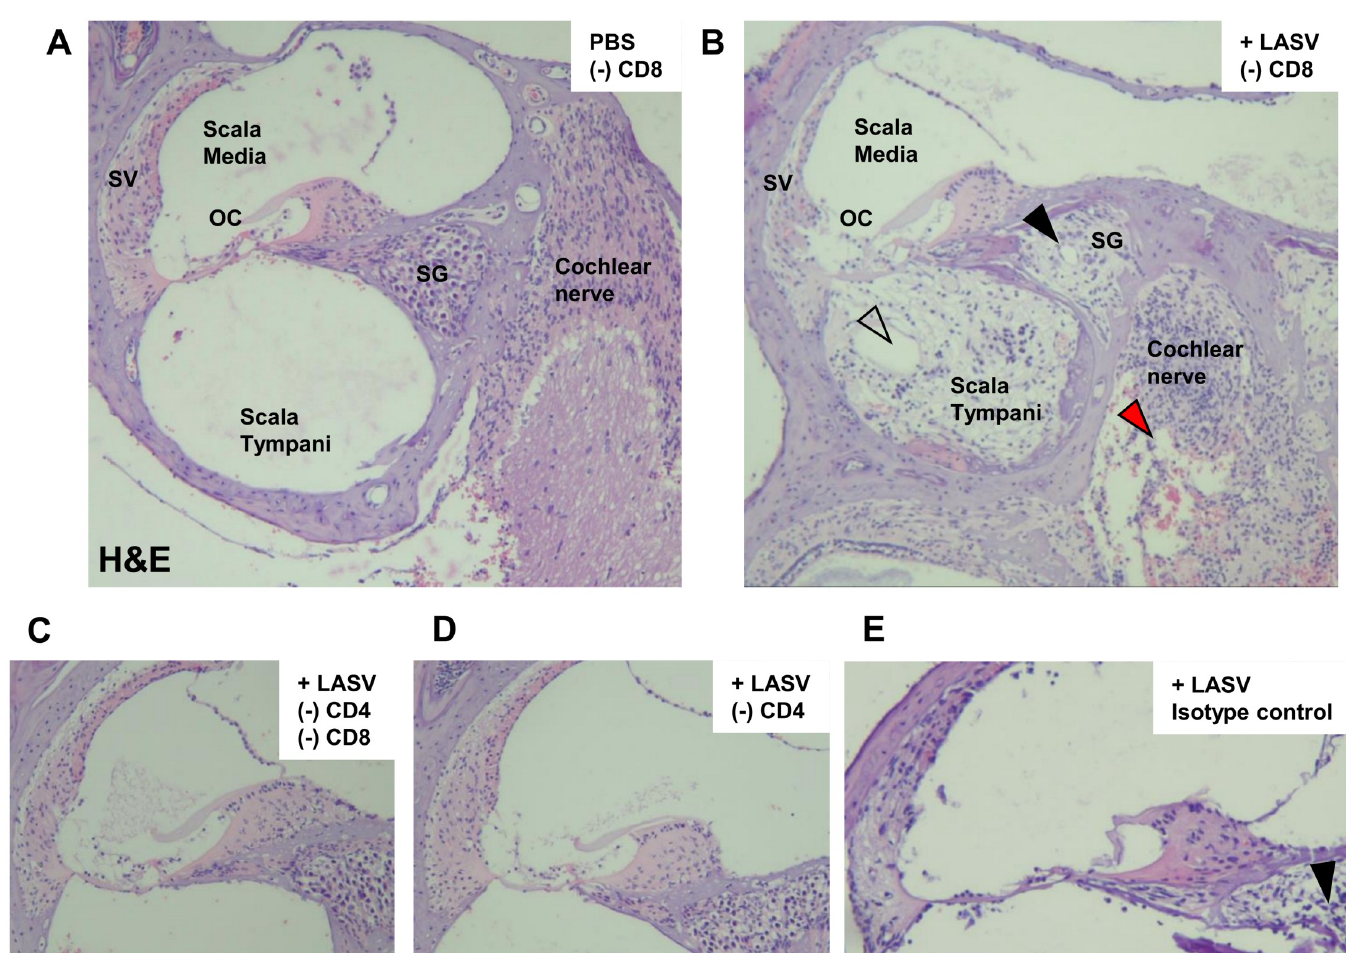
Fig 7. Damage on auditory neurons in LASV-infected mouse inner ear. Representative images of the cochlear ducts in the mouse from uninfected (A) , CD8-depleted (B) , CD4/8-depleted (C) , CD4-depleted (D) , isotype control group (E) . LASV infection induced significant damage to the inner ear in mice depleted of CD8 T-cells, whereas mice depleted with both CD4 and CD8 T-cells or depleted only with CD4 T-cells did not show any damage. Structural damage, hemorrhage and lymphocyte infiltration were observed in the spiral ganglion (black arrowhead), cochlear nerve (red arrowhead), and scala tympani (white arrowhead). Thinning of the stria vascularis (SV) was frequently observed associated with damage (B). Hemorrhage was observed in areas vascular-rich perineural areas. OC, organ of Corti; SG, spiral ganglion; SV, stria vascularis. 50x magnification. Samples were collected at time of euthanasia: (A) 98 d.p.i., (B) 98 d.p.i., (C) 98 d.p.i., (D) 98 d.p.i., (E) 93